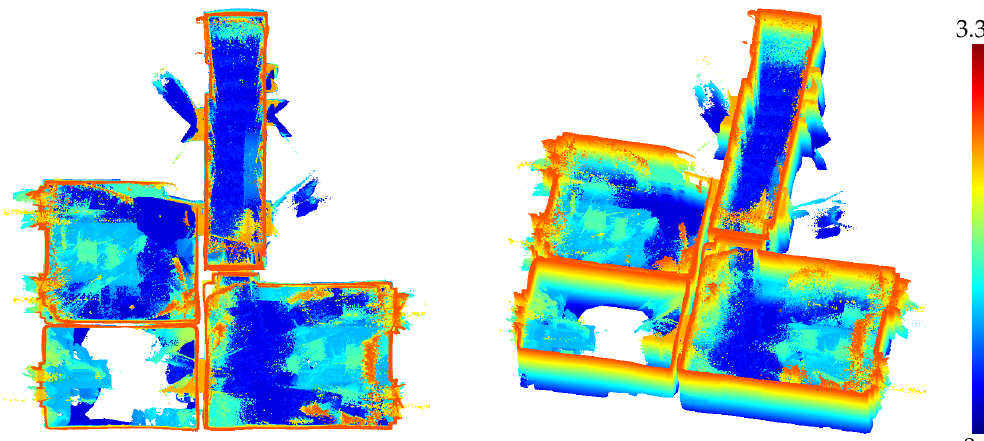
Figure 19. Point cloud of an indoor office environment captured by the HoloLens range sensor. The colors visualize point height with blue for the lowest and red for the highest points. The ceiling is removed for better